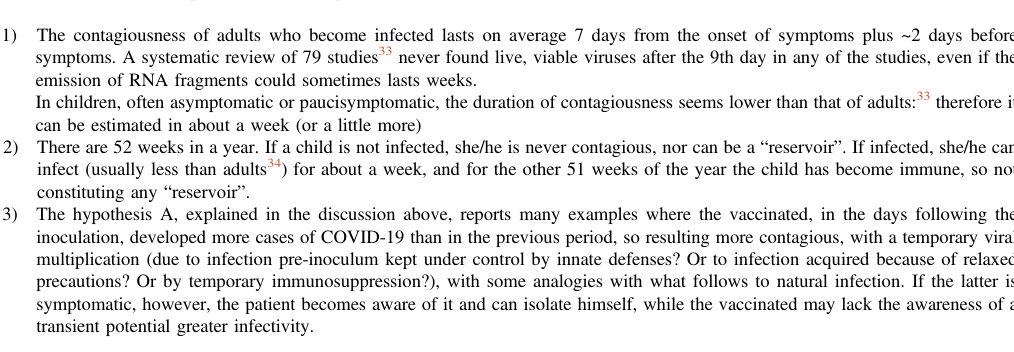
csv - Protezione Civile data table.csv used for the development of the comparison graphs 2020 versus 2021. https://covid19.zappi.me/table/ - Protezione Civile data table (simple format, same data as the previus.csv file) used for the development of the comparison graphs 2020 versus